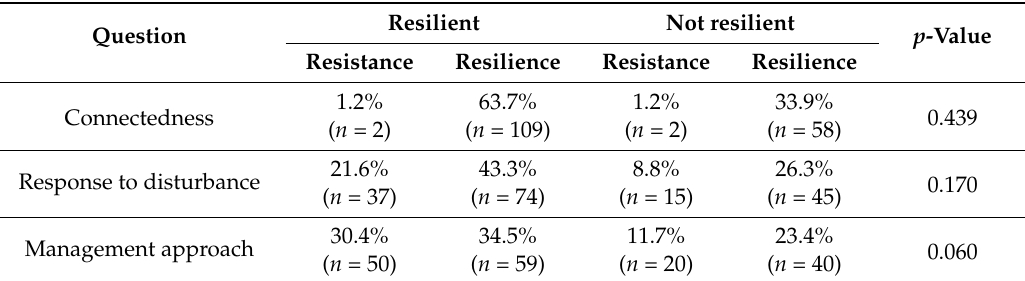
Table 2. Distribution of perception of regional resilience to flooding by resilience/resistance-based internal representations ( N =